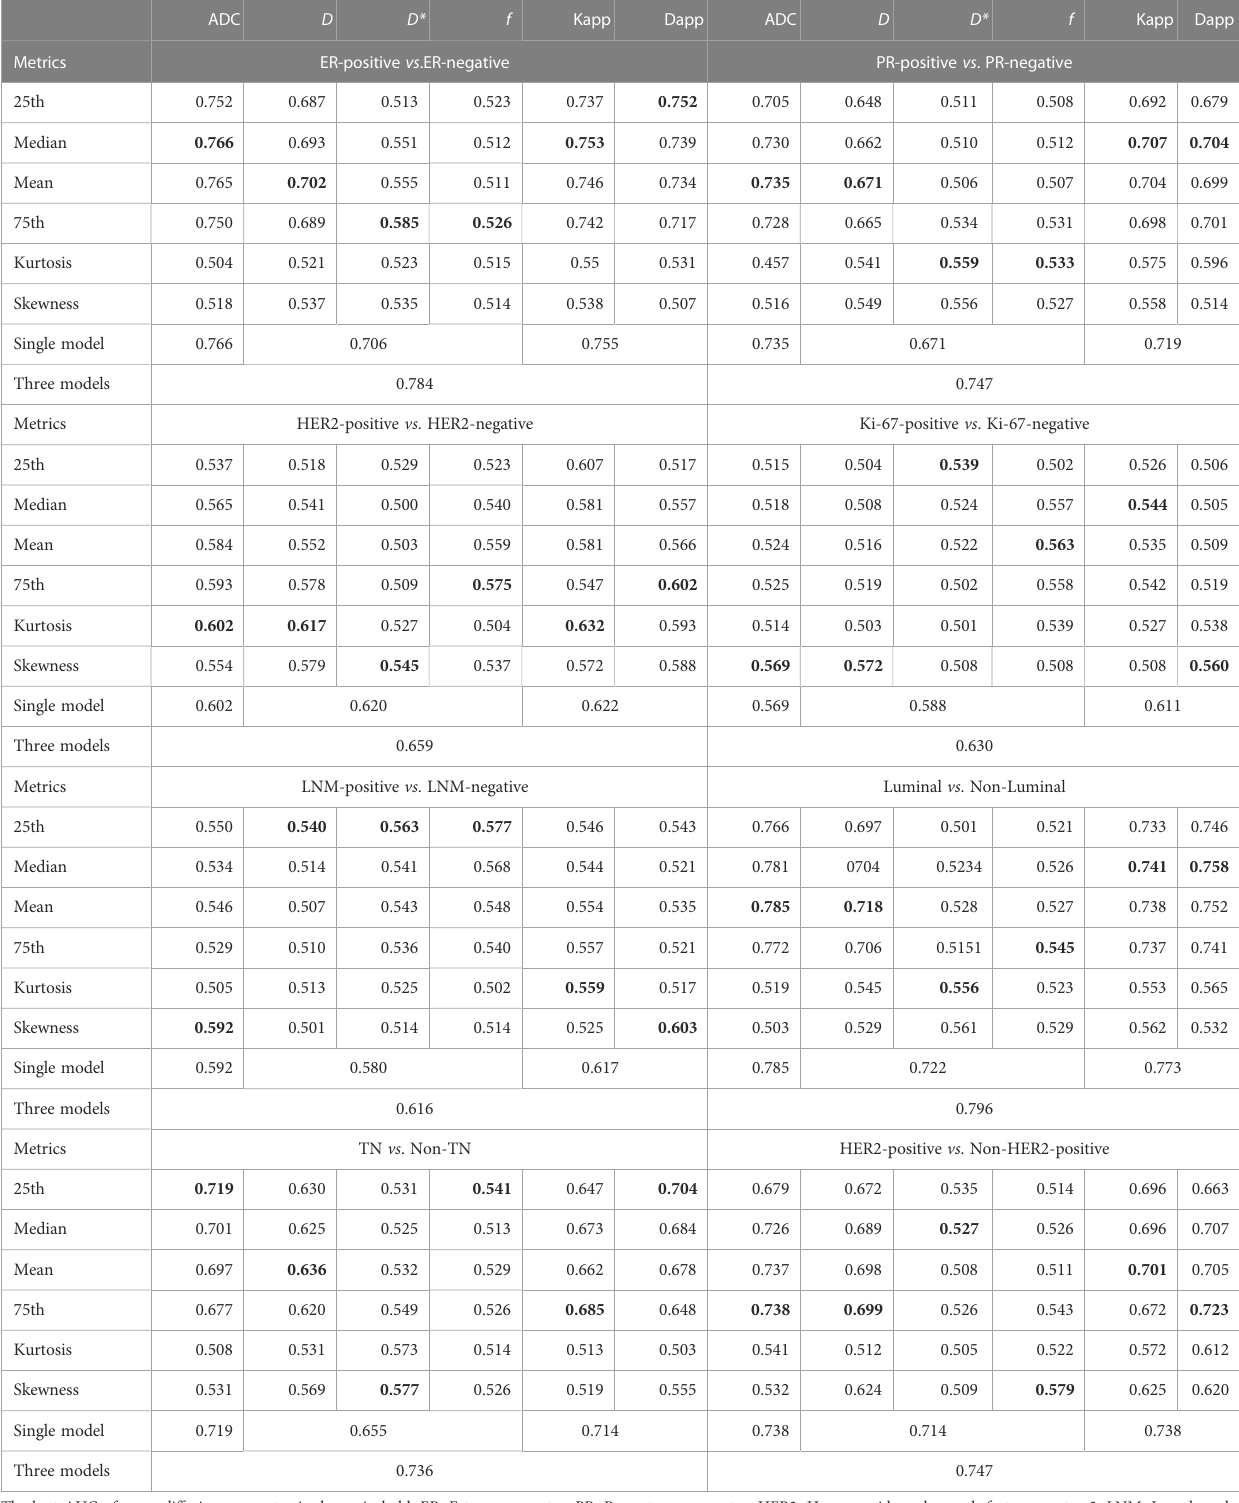
TABLE 5 AUC of histogram metrics derived from mono, IVIM, and DKI models to predict molecular prognostic factors and subtypes. ADC D D*